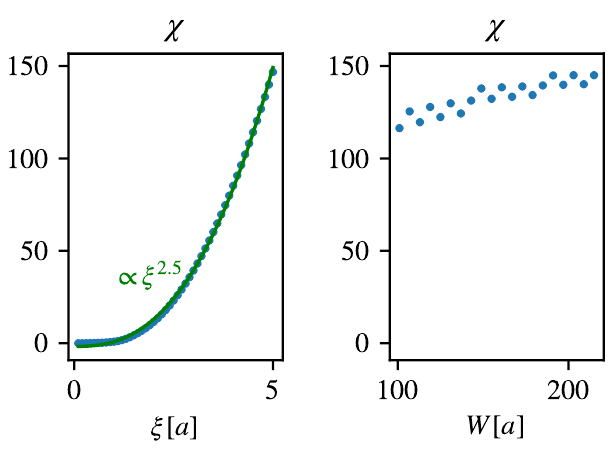
Figure 7: Valley polarization χ , defined in Eq. (5.2). (a) Dependence of χ on the impurity range ξ at a width W = 201. (b) Width dependence of χ at ξ = 5. Other = 0.3 t , β = 1.5, and E = 0.3 t parameters are µ b F